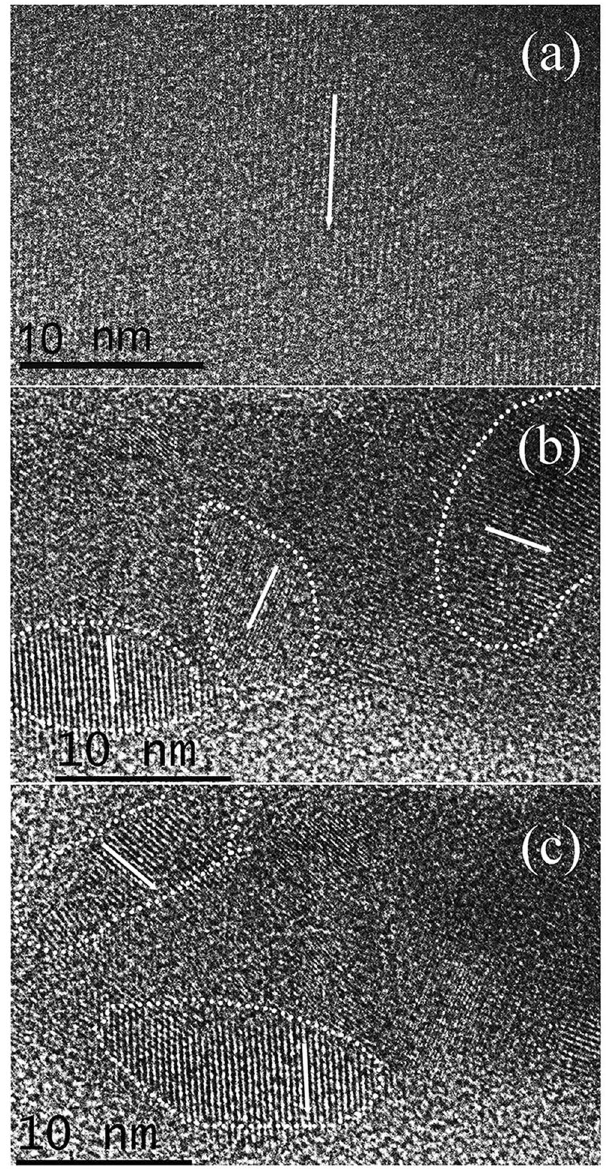
Figure 4. TEM images of the GaSb samples after decompression from different pressures. ( a ) 5.0 GPa; ( b ) 10.0 GPa; ( c ) 25.0